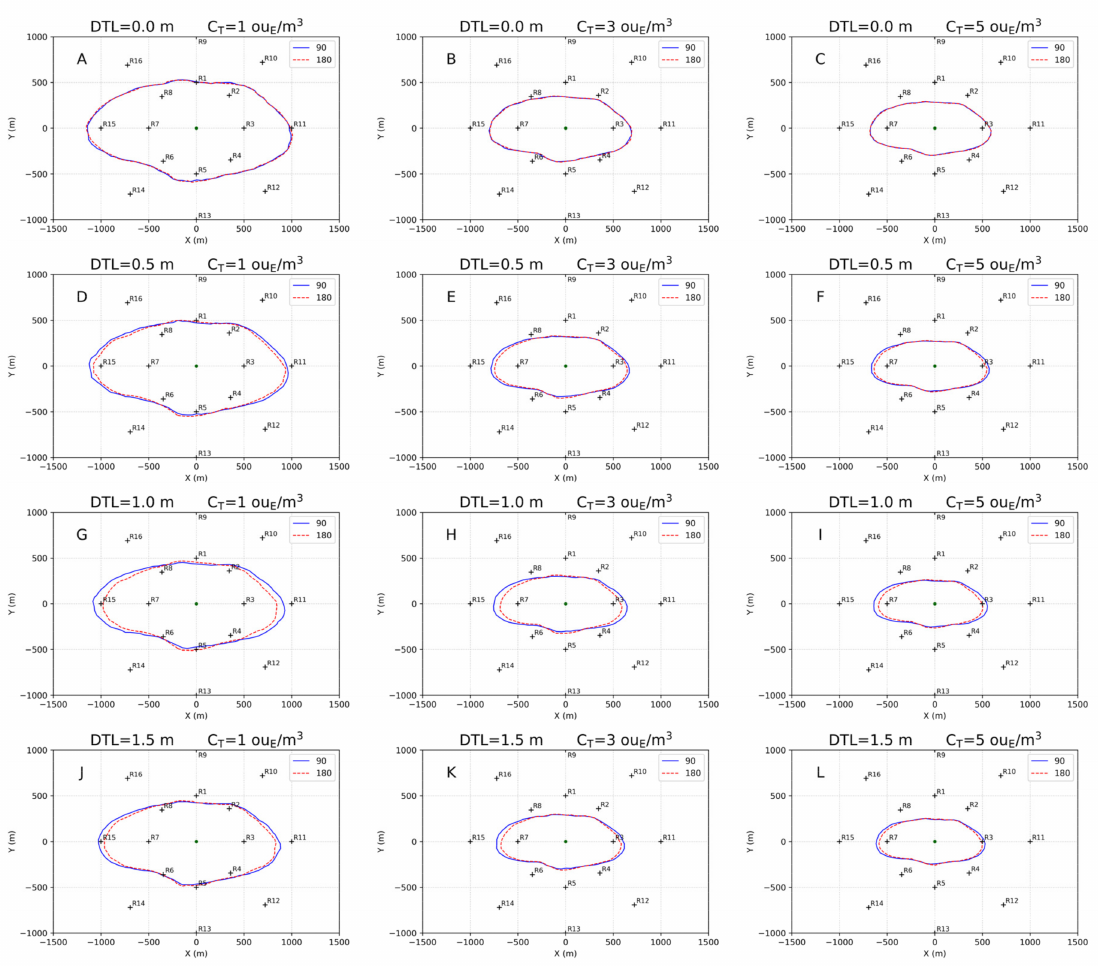
Figure 13. Tank L18_W5. Separation distances calculated for the base case (top row) and as a function of the tank orientation and DTL of 0.5 m (second row), 1.0 m (third row) and 1.5 m (bottom row). Concentration thresholds are 1 ouE/m 3 (left column), 3 ouE/m 3 (central column) and 5 ouE/m 3 (right column). The dark green circle represents the centroid of the sources, while the black crosses represent the discrete receptors. ( A ): DTL = 0.0 m, C T = 1 ouE/m 3 . ( B ): DTL = 0.0 m, C T = 3 ouE/m 3 . ( C ): DTL = 0.0 m, C T = 5 ouE/m 3 . ( D ): DTL = 0.5 m, C T = 1 ouE/m 3 . ( E ): DTL = 0.5 m, C T = 3 ouE/m 3